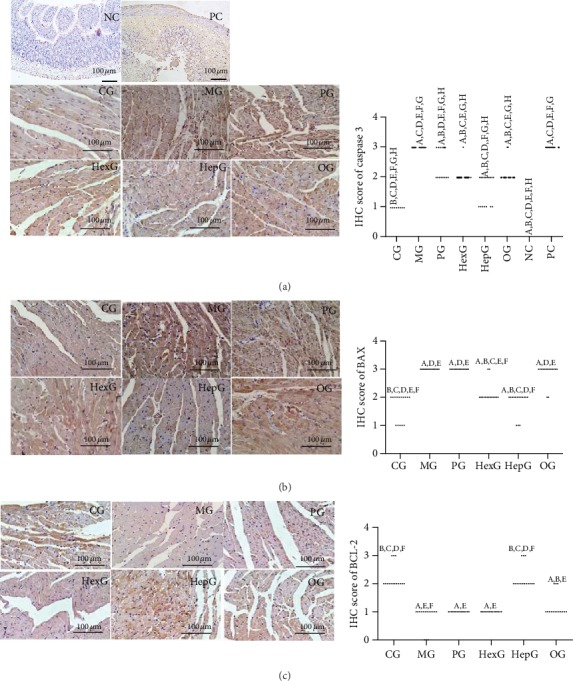
Histoimmunity analysis of apoptotic factors. (a) Caspase 3. (b) BCL-2-associated X protein (BAX). (c) B cell lymphoma 2 (BCL-2). CG: control group; MG: model group; PG: chitopentaose-treated group; HexG: chitohexaose-treated group; HepG: chitoheptaose-treated group; OG: chitooctaose-treated group; NC: negative control group without primary antibody; PC: positive control group with the primary antibody for β-actin. n = 8 for each group. Ap < 0.05 vs. the CG group, Bp < 0.05 vs. the MG group, Cp < 0.05 vs. the PG group, Dp < 0.05 vs. the HexG group, Ep < 0.05 vs. the HepG group, Fp < 0.05 vs. the OG group, Gp < 0.05 vs. the NC group (negative control group without primary antibody), and Hp < 0.05 vs. the PC group (positive control group with primary antibody for β-actin).